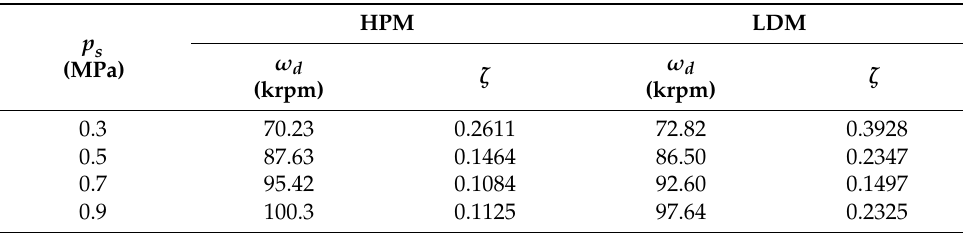
Table 3. Experimental natural frequency and damping ratio of signal y 2 at different supply pressures; the results were obtained with HPM and